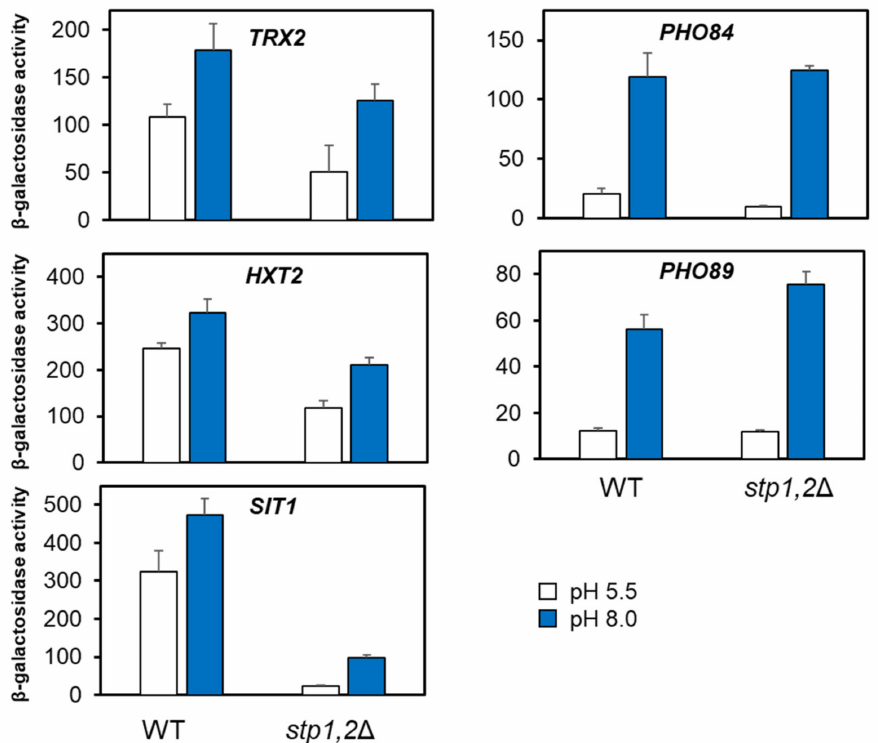
Figure 8. Effect of the lack of Stp1 and Stp2 transcription factors on the expression of diverse alkali- induced gene reporters. The indicated reporters were introduced in strain 23344c (WT) and KW023 ( stp1 ∆ stp2 ∆ ) and grown as in Figure 6. LacZ activity was measured after 1 h of induction at alkaline pH. Data are mean ± SEM from 4 to 10 independent